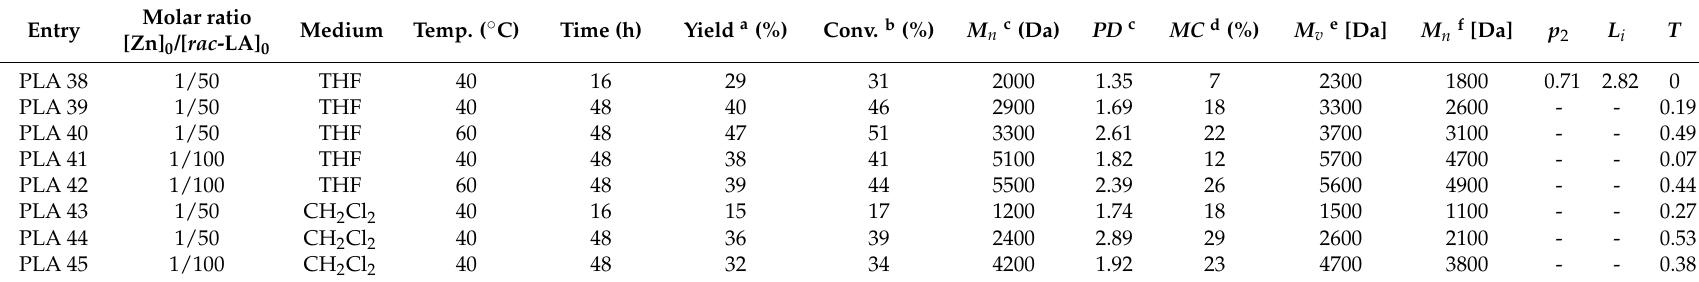
Table 4. Ring-opening polymerization of rac -LA in tetrahydrofuran and dichloromethane in the presence of ZnEt 2 /PGAc catalytic